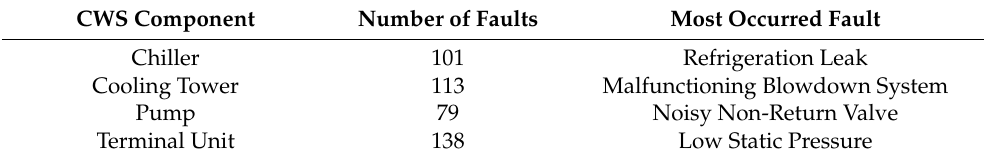
Table 9. Number of CWS